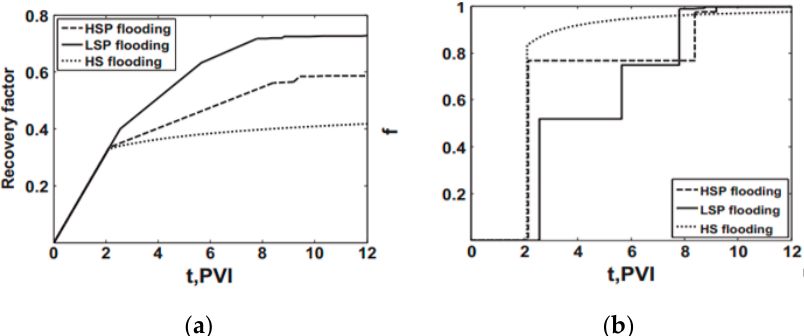
Figure 20. Analytical solution results showing the effects of LSPF on ( a ) oil recovery and ( b ) water cut rates [131]. Reproduced with permission from Borazjani et al., J. Pet. Sci. Eng. ; published by Elsevier, 2016.